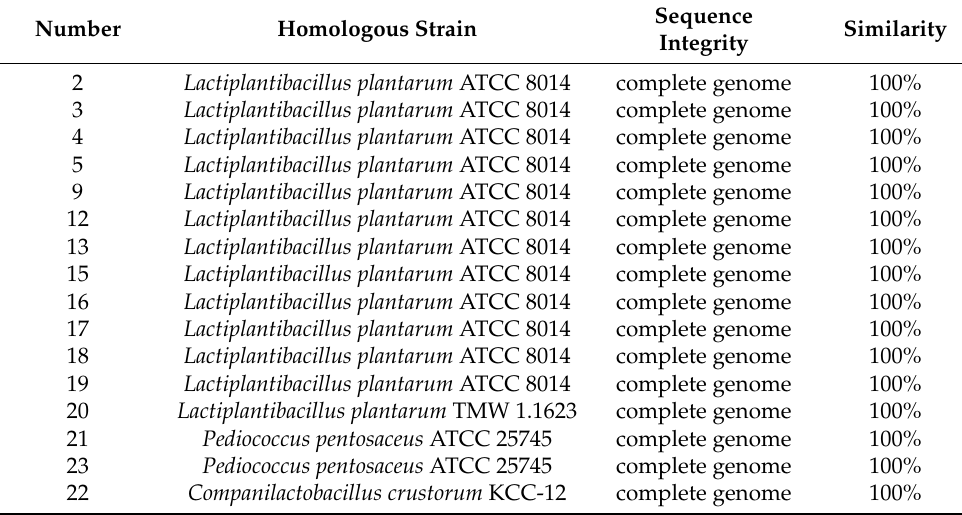
Table 3. Homology analysis of LAB strains from Xinjiang sourdough.